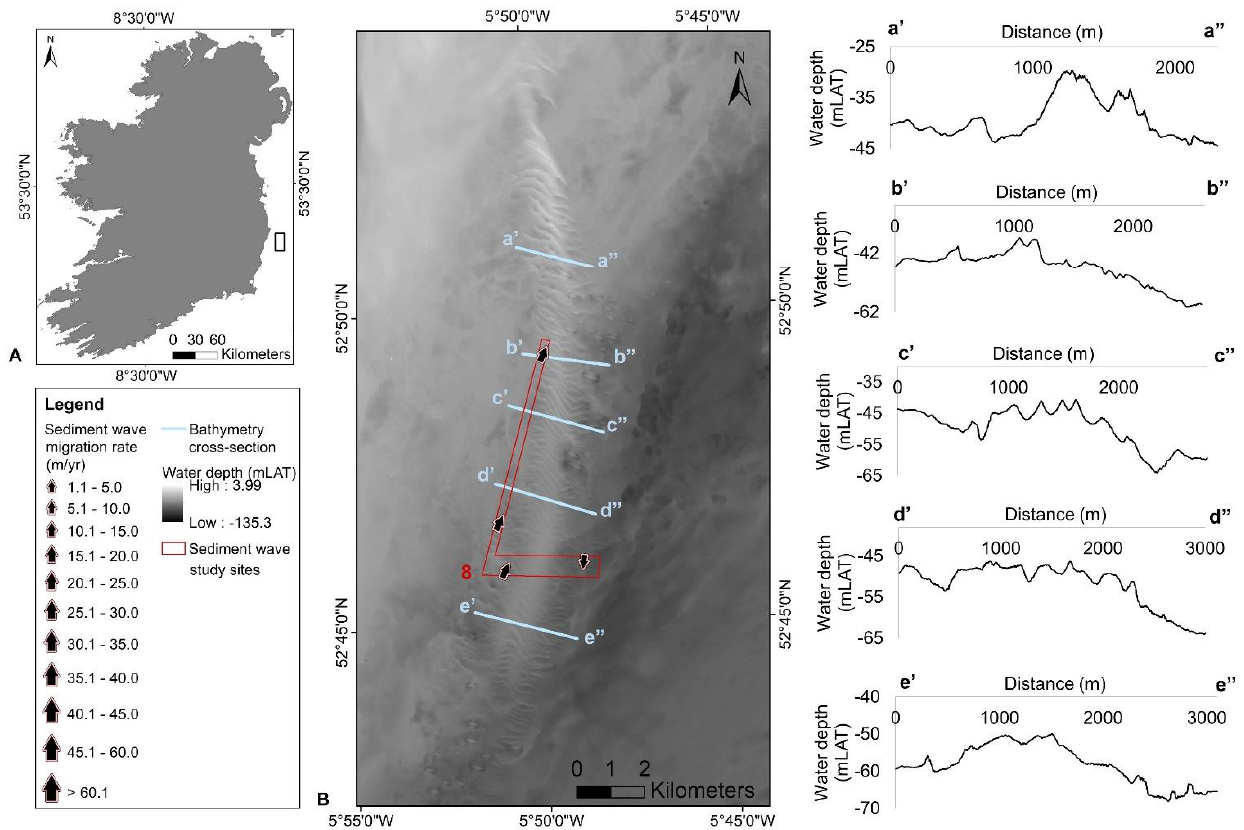
Figure 10. Sediment wave dynamics at offshore independent sediment wave assemblage at site 8 in the Irish Sea. Location of cross-sections a to e are provided in ( B ). Location of ( B ) is given in ( A ). Bathymetry. Source: composite map produced from INFOMAR datasets (https://www.infomar.ie/data [Accessed: 10 June 2021]) (see Section 3.1).